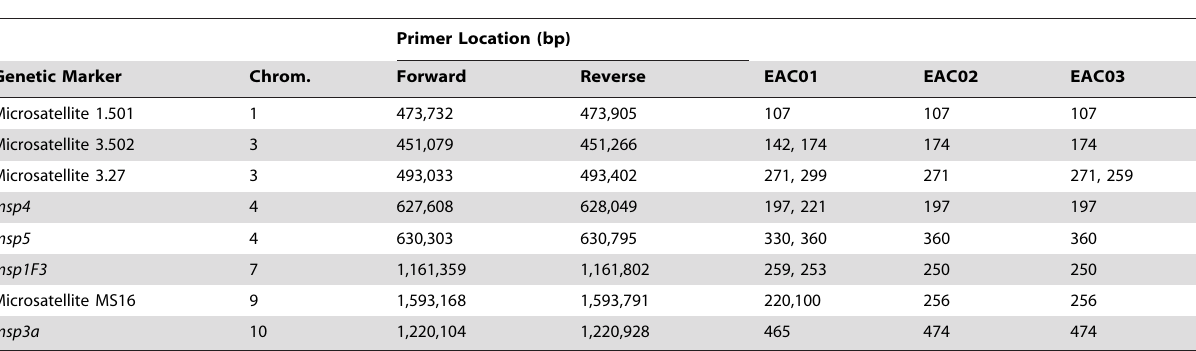
Table 3. Genomic location and band size of eight genetic markers in P. vivax [37].